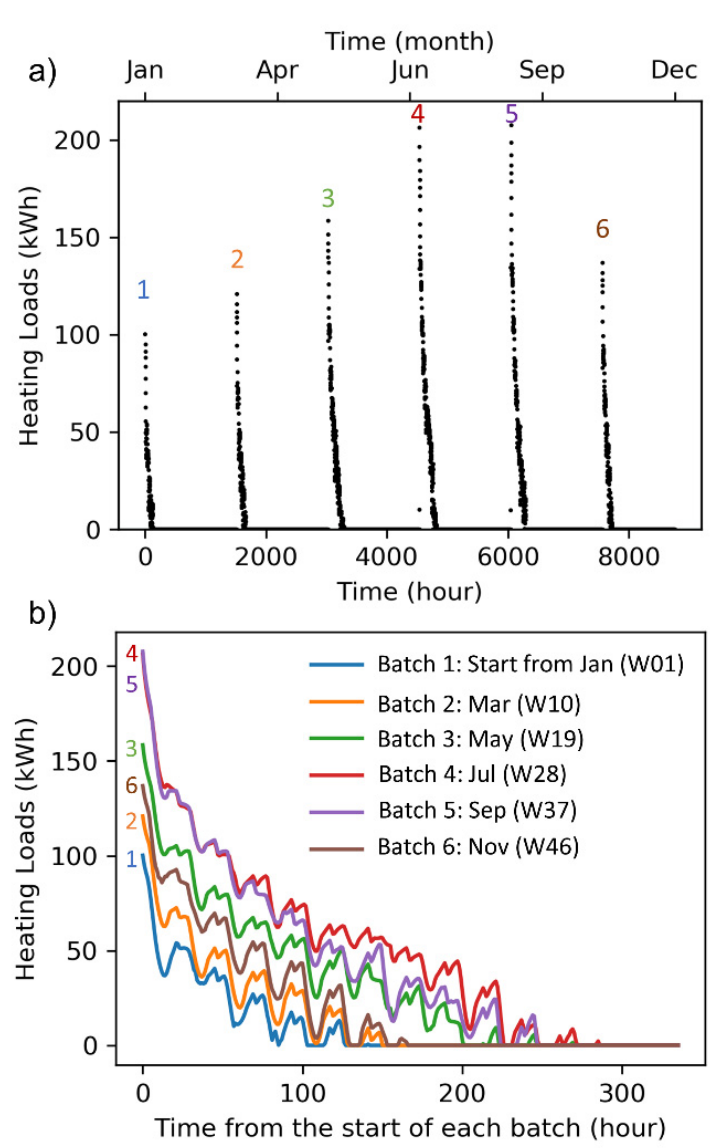
Figure 2. Hourly heating demand of the chicken shed: ( a ) yearly loading pattern showing the six batches; ( b ) details of these six heating cycles over one year.